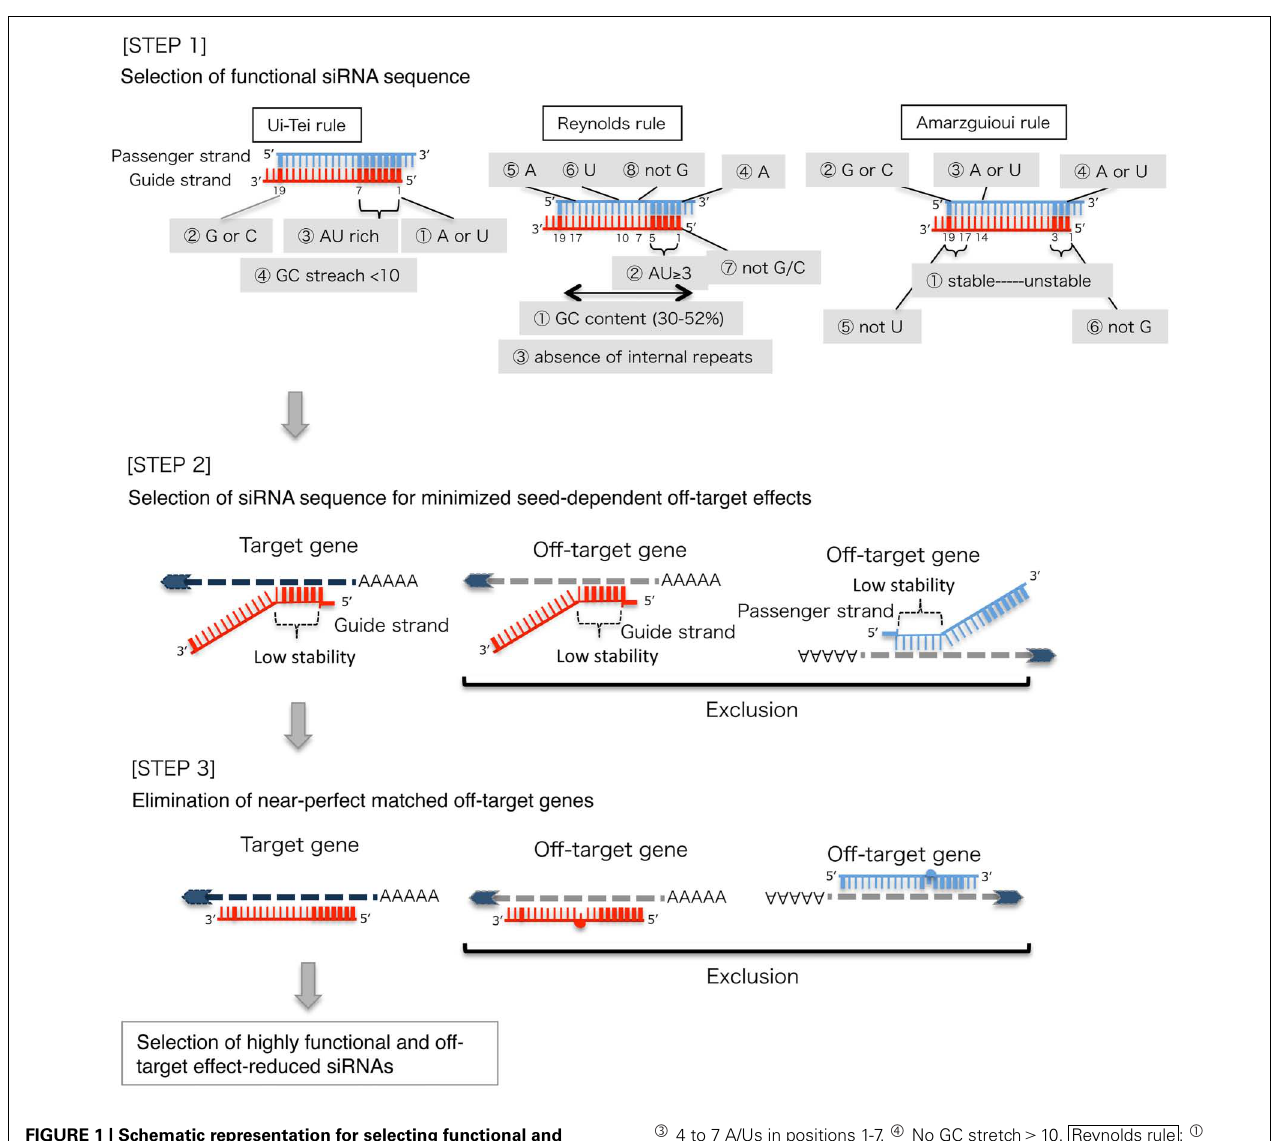
FIGURE 1 | Schematic representation for selecting functional and off-target effect-reduced siRNAs. Selection of highly functional siRNA by Ui-Tei, Reynolds, Amarzguioui rules, or the combination of them (STEP 1). Selection of siRNAs with low stability in the seed-target duplexes (STEP 2). Elimination of siRNAs with near-perfect matched sequences to non-target genes (STEP 3). In each rule, the nucleotide position indicates the number of nucleotide counted from 5 (cid:2) terminal of the guide strand. Ui-Tei rule: (cid:2) A/U at position 1. (cid:3) G/C at position 19.